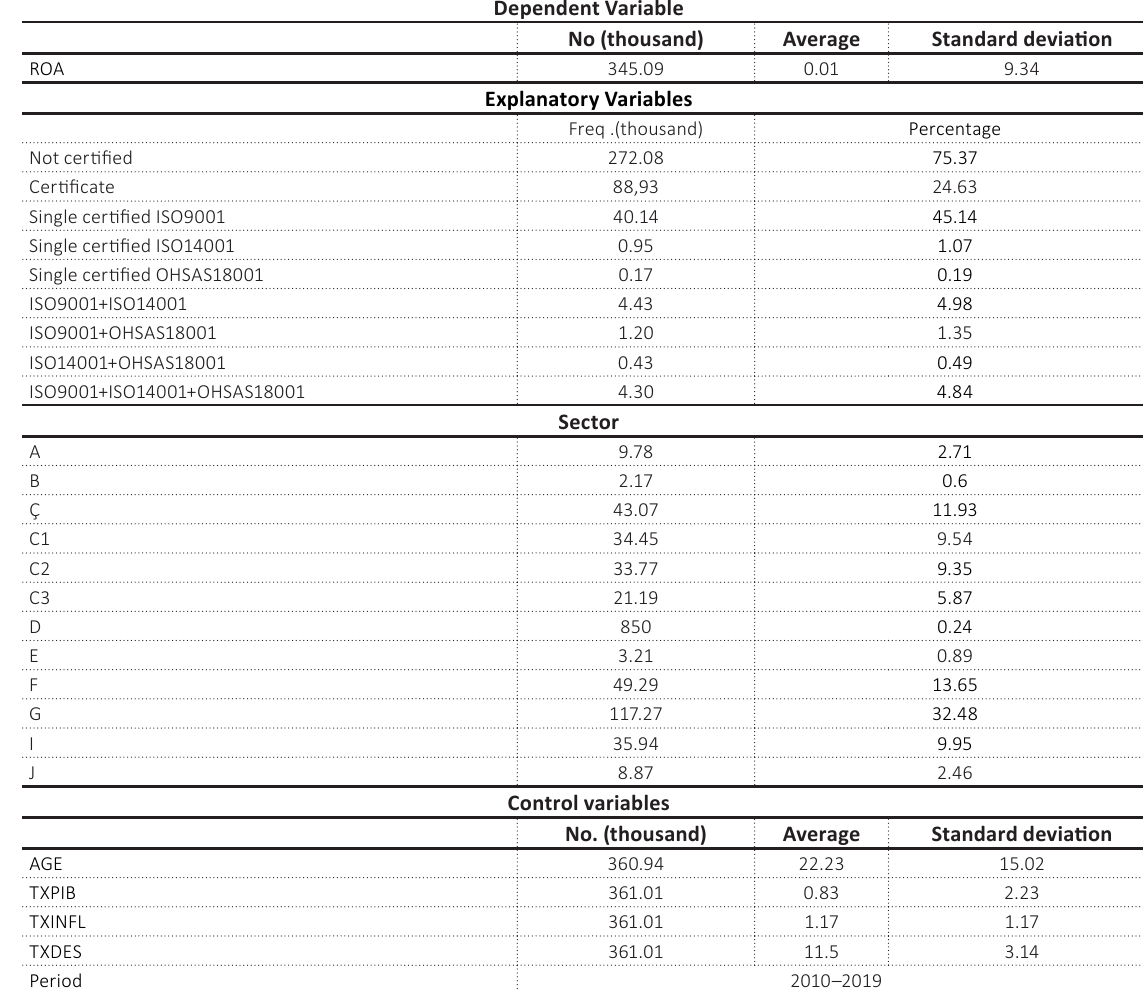
Table 3. Summary of dependent and independent